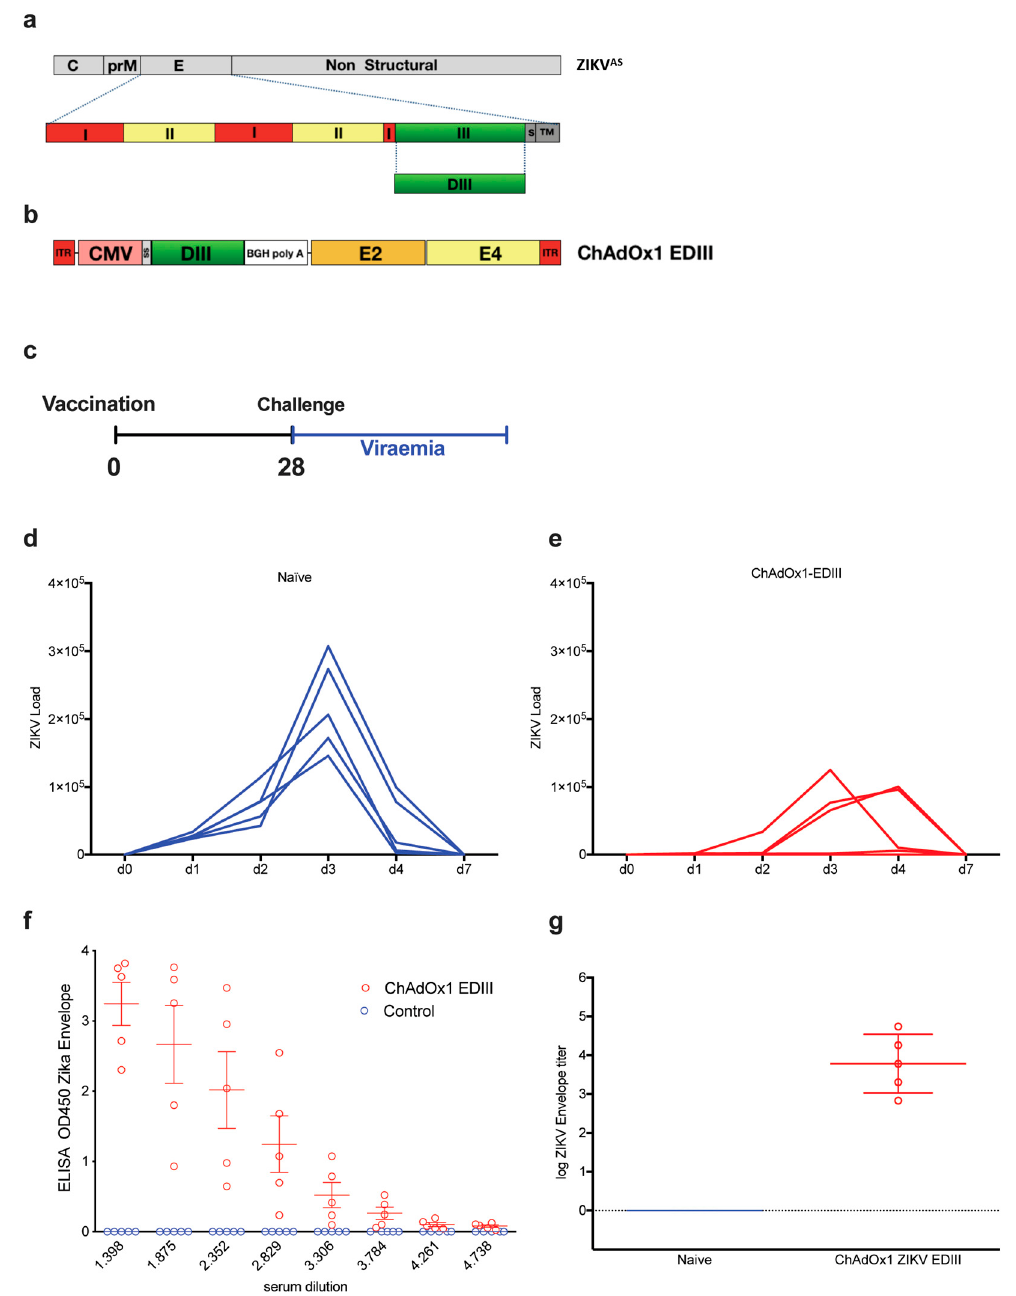
Figure 4. Assessment of protective efficacy induced by the ChadOx1-EDIII vaccine. ( a ) Schematic representation of the ZIKV AS genome in gray, designed from an Asian lineage (ZIKA AS ). Bottom row represents a magnified schematic of the envelope of ZIKV, with domains I, II, and III, shown in different colors. DIII is shown in green. The EDIII coding region was used to produce the recombinant adenoviral vector, containing the ZIKV EDIII ( b ). ( c ) Vaccination strategy and timeline for a challenge with a ZIKV of a homologous Asian lineage [37]. Naïve ( d ) and vaccinated ( e ) BALB/c mice ( n = 5) were intravenously challenged with 100 PFU of ZIKV-BR strain. Upon ZIKV challenge, viral loads were monitored for up to seven days. Graphs show days post-challenge on the x-axis versus viral loads on the y-axis. Continuous blue and red lines represent one mouse each, for each of the control (d) and vaccinated groups (e). ( f ) ELISAS from the control and vaccinated groups, OD450 were recorded from 3-fold dilutions. ( g ) Log of endpoint titers from ELISA are shown.